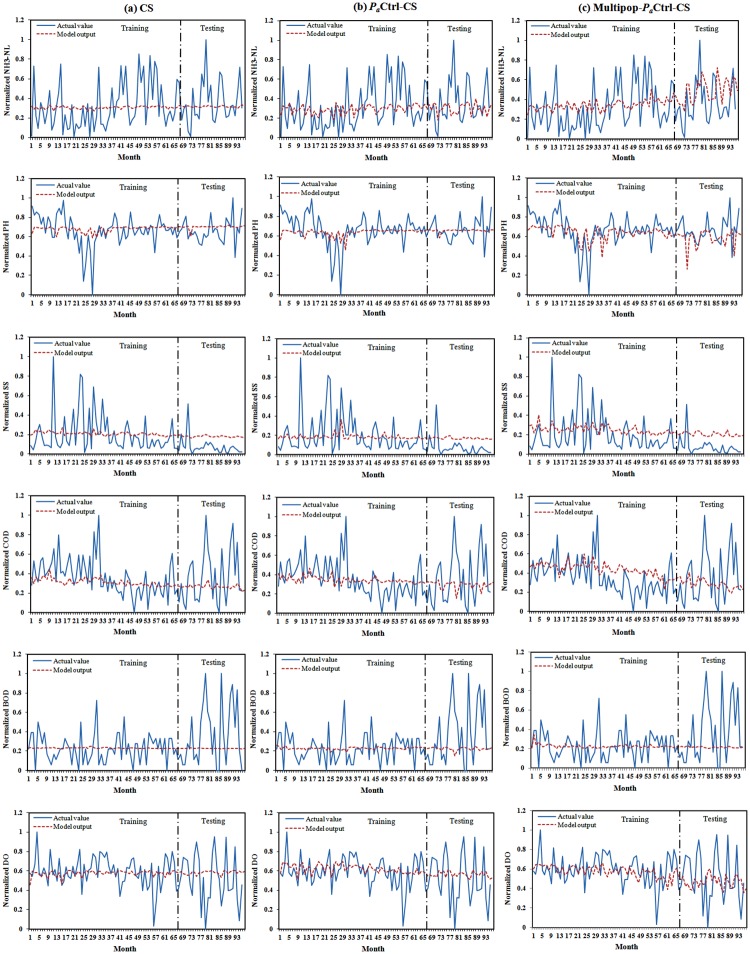
Comparison of actual value and model output for different features in: (a) CS,(b) PaCtrl-CS and (c) Multipop-PaCtrl-CS.